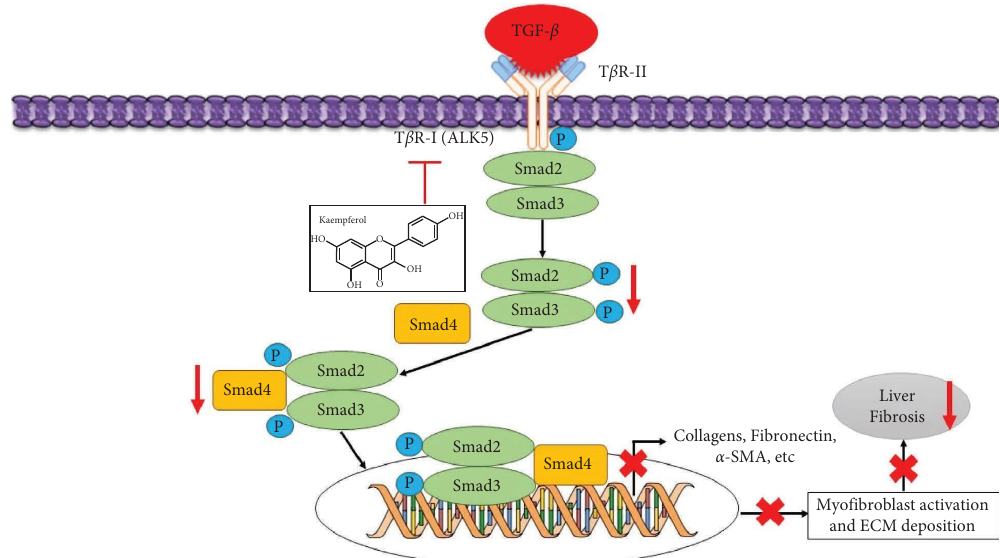
Figure 7: Schematic diagram depicting possible mechanisms kaempferol targets in the T β R-1 (ALK5) signaling pathway and downregulates the phosphorylation of Smad2 and Smad3. Inhibition ( ⟞ ) and red arrows